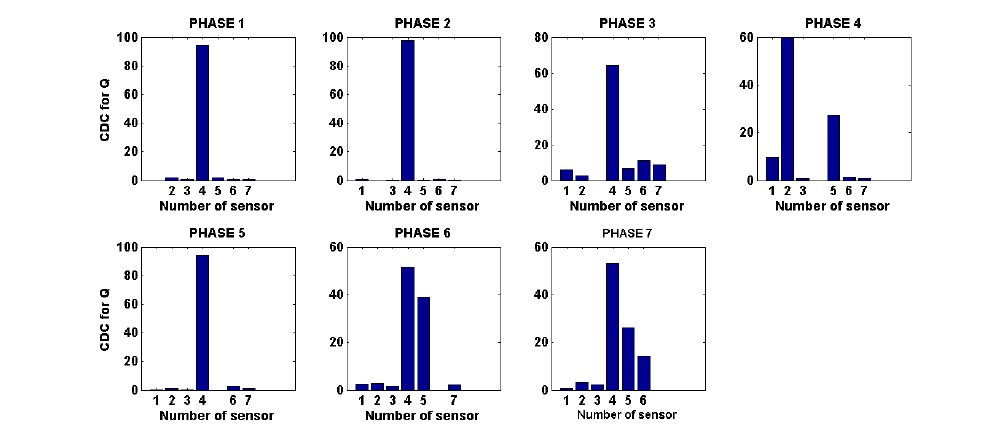
Figure 7. Damage contribution